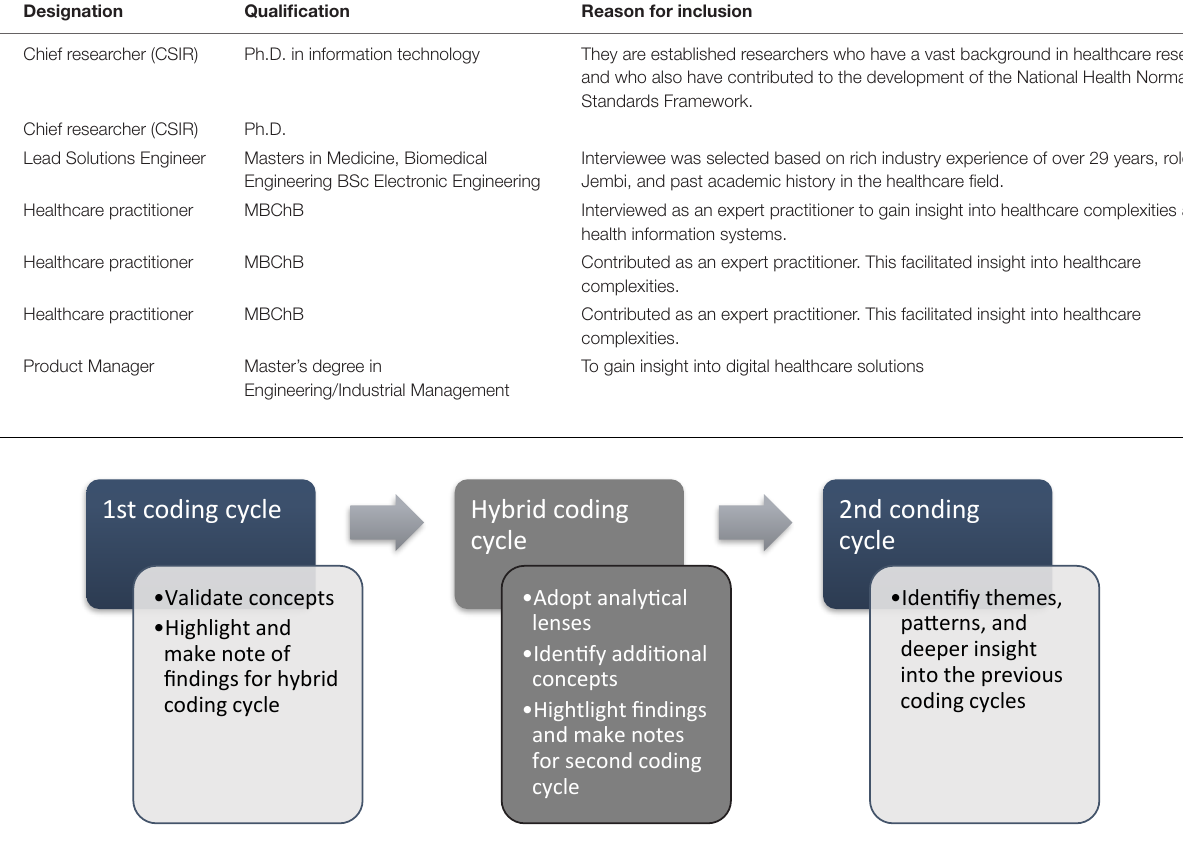
TABLE 1 | Interviewee and framework ranking participants.